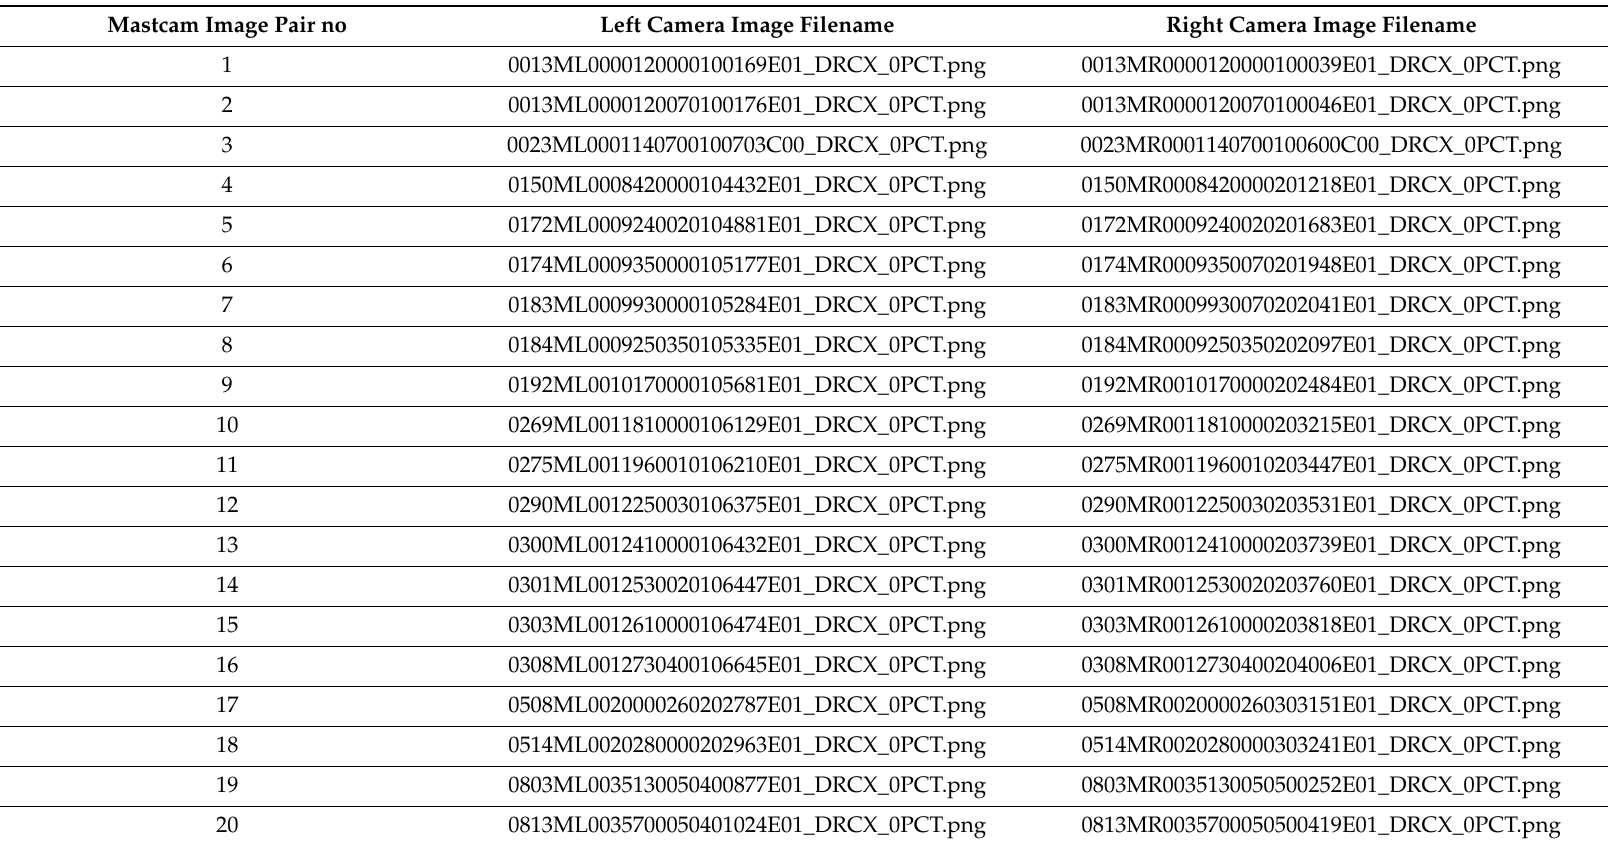
Table 6. List of 20 Mastcam image pairs